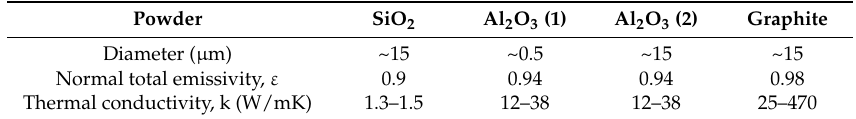
Table 1. Summary of the diameters and emissivity ε of the powders. The base of 1050 Al has an emissivity ε of 0.11 and a heat conductivity k of 235 W/mK.